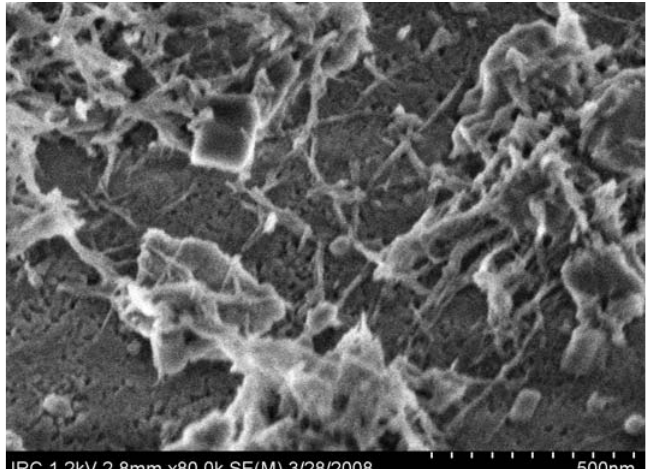
Figure 11. Growth of C-S-H around SWCNT bundles (rods in image) at 135 minutes of hydration of an OPC composite